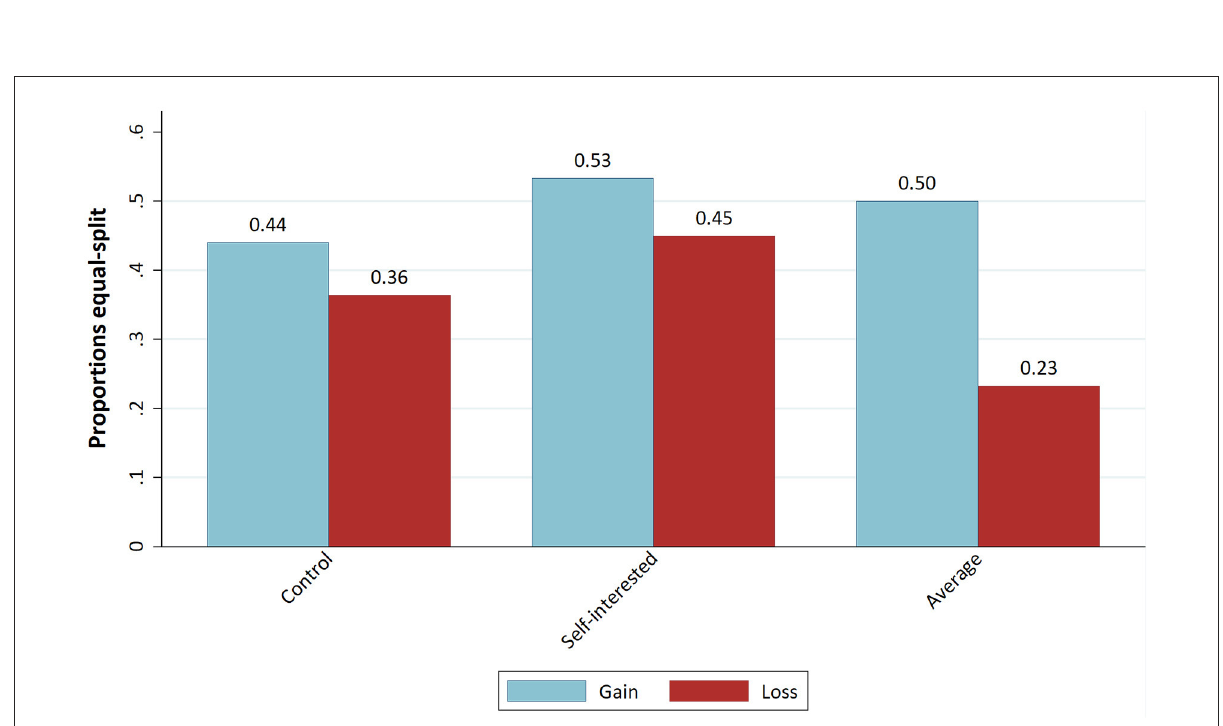
FIGURE4 Proportion of equal